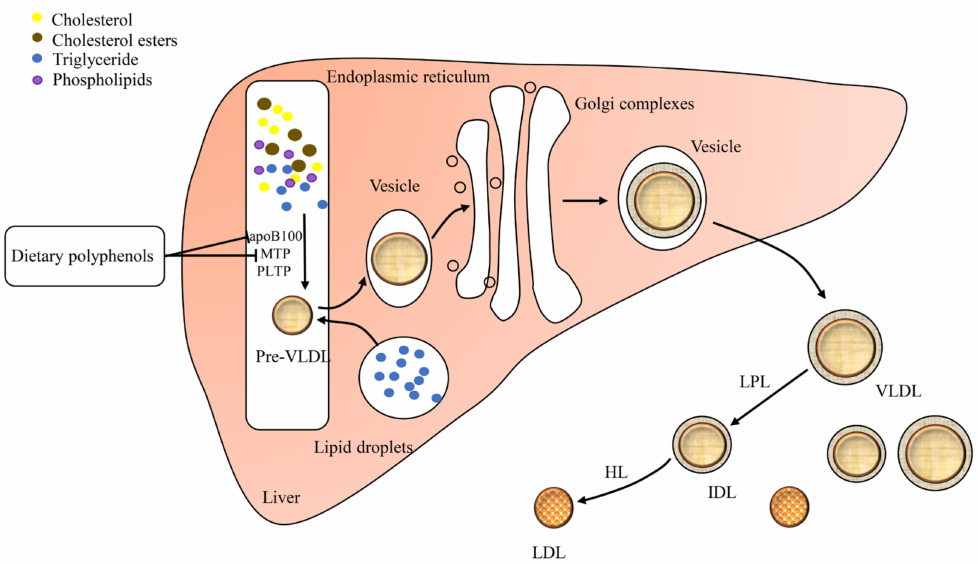
Figure 2. VLDL assembly and secretion. PLTP, phospholipid transfer protein; VLDL, very low-density lipoprotein; LPL, lipoprotein lipase; IDL, intermediate density lipoprotein; HL, hepatic lipase; LDL, low-density